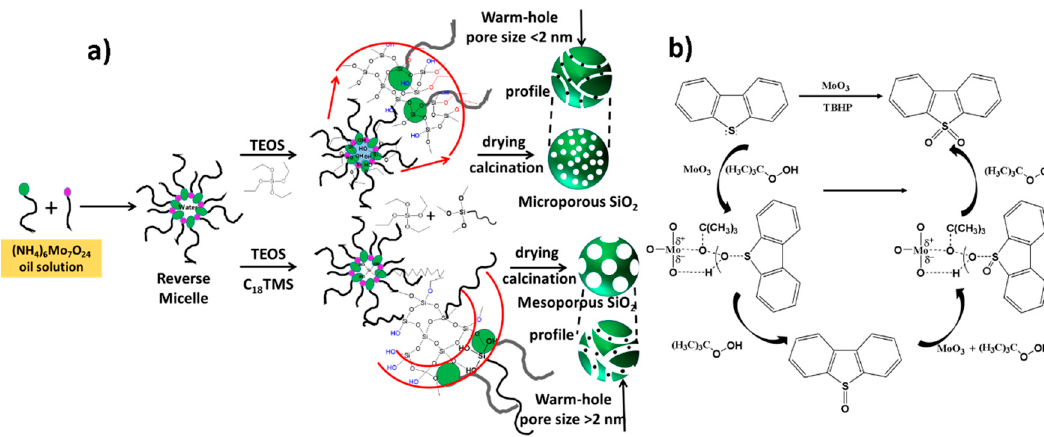
Figure 4. ( a ) Schematic representation for the formation of subnano-MoO 3 / ultrasmall mesoporous silica nanoparticles (UMSN); ( b ) catalytic mechanism of MoO 3 catalyzing dibenzothiophene (DBT) oxidation in the presence of TBHP (tert-butyl hydro peroxide) [106].